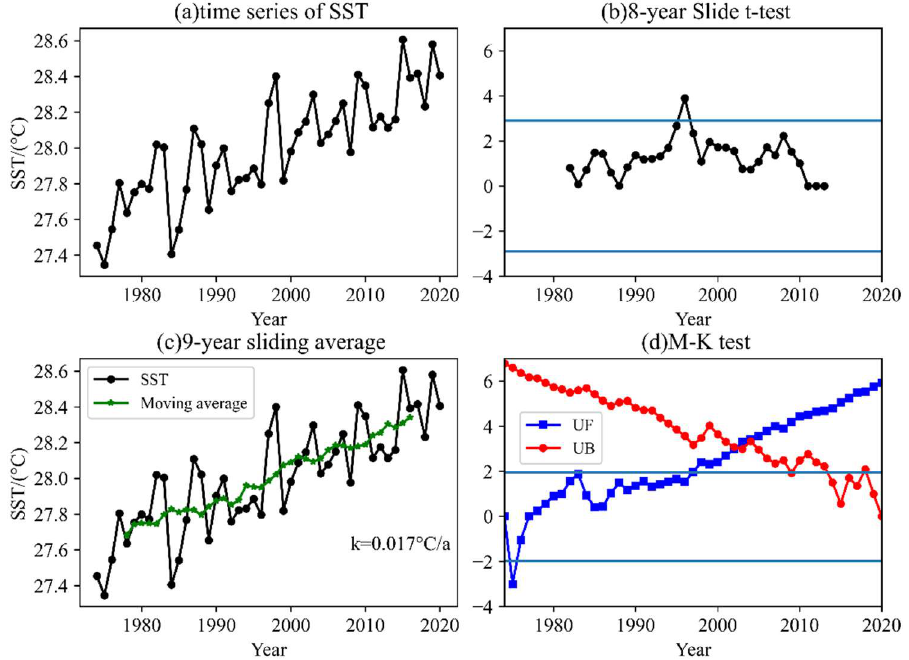
Figure 2. Time domain variation of tropical western Indian Ocean SST. ( a ) interannual variability; ( b ) sliding-t test; ( c ) moving average; ( d ) M–K mutation test.